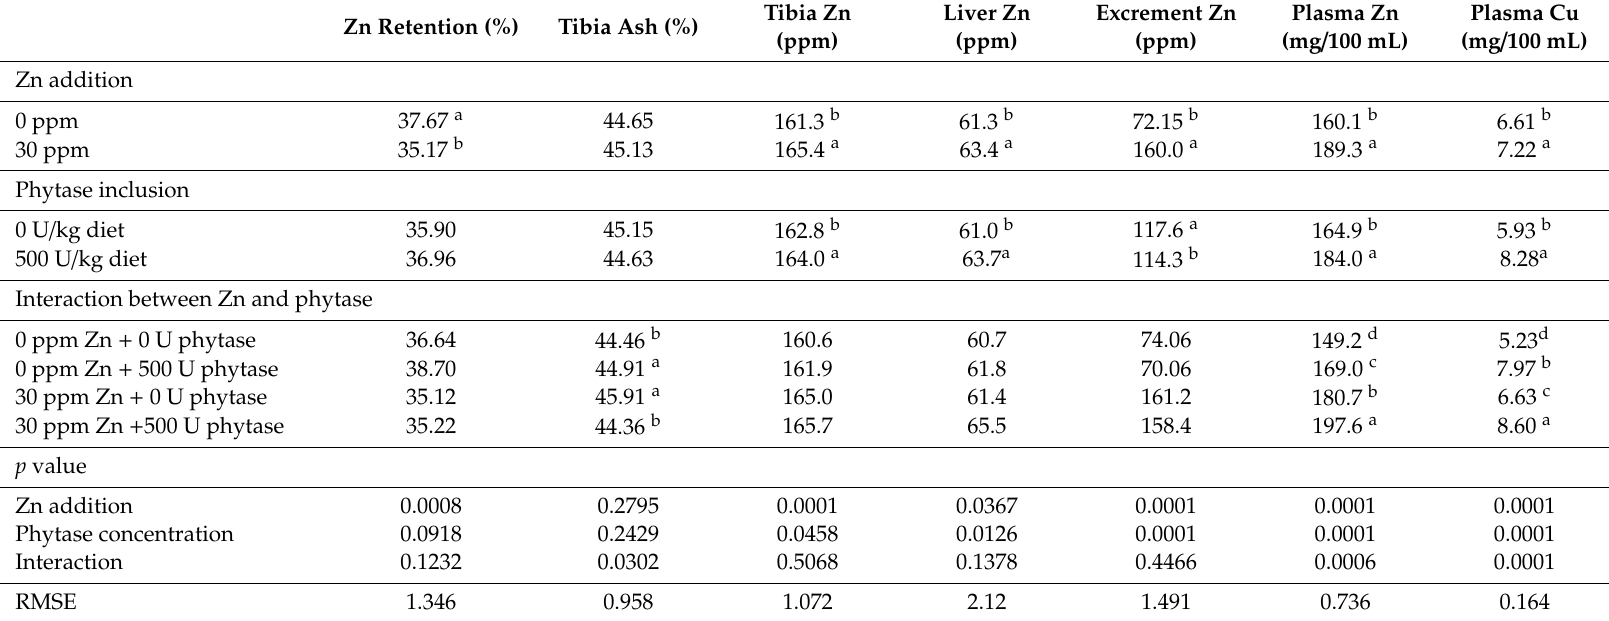
Table 3. E ff ect of zinc supplementation, with and without phytase addition, on Zn retention and tissue and excrement concentrations, and plasma Zn and Cu concentrations in White Pekin ducks